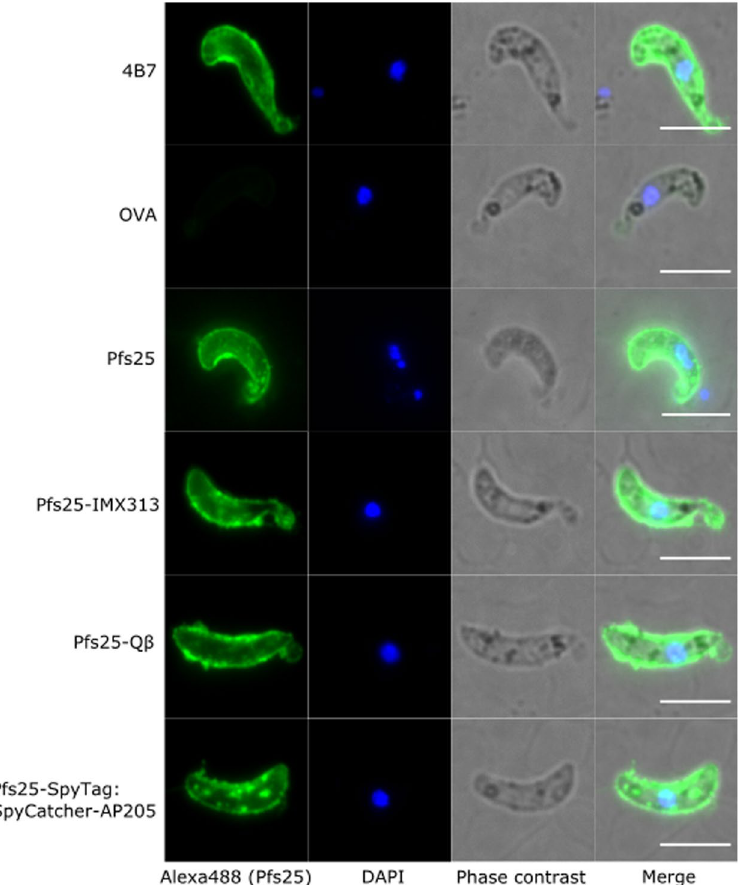
Figure 3. Binding of anti-Pfs25 IgG to native antigen. Ookinetes of P . berghei transgenic for Pfs25 (Pfs25DR3) were stained with 4B7 (positive control) or pooled post boost sera from mice immunised with one of the nanoparticle vaccines, monomeric Pfs25 or ovalbumin (OVA) (negative control). Antibody binding was detected by Alexa Fluor ® 488-conjugated goat anti-mouse IgG (green) and the DNA was stained with DAPI (blue). Phase contrast as well as merged view are also shown. White bars correspond to 5 μ